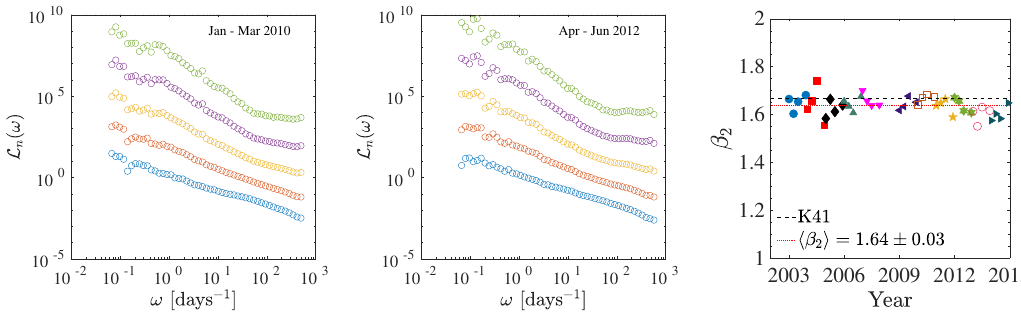
Figure 9. Left panel : the Hilbert spectra L n ( ω ) for n = 1 → 5, obtained for sample dated January–March 2010. A power-law range can be observed over the frequencies ω ∈ [ 0.3,0.02 ] days − 1 (from 20 min up to ∼ 3 days). The generalized spectra have been shifted for clarity. Central panel : Same as previous case, but for sample April–June 2012. In addition, in this case, the power-law range is present but in slightly smaller range ω ∈ [ 1,0.025 ] days − 1 (from 30 min up to ∼ 1 days). Right panel : Temporal evolution of the slope β 2 relative to the second order generalized Hilbert spectra ( L 2 ( ω ) ). The results are in good agreement with the classical Kolmogorov spectrum β ≈ 5/3 ( horizontal dashed line ), characteristic of the inertial sub-range turbulence. The horizontal dotted line represents the average value (cid:104) β 2 (cid:105) . Each point represents a 90-day sample.